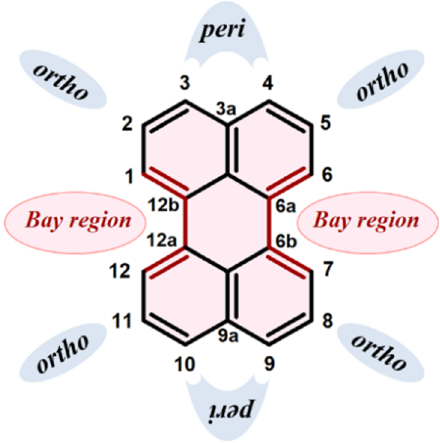
Figure 1. Structure and specific positions of perylene.